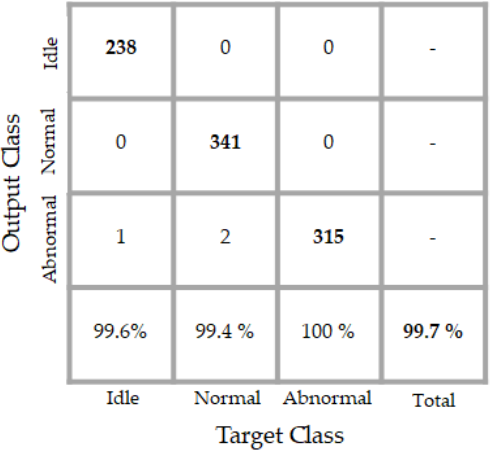
Figure 16. Confusion matrix of the classification results. “Target class” denotes the labels and “output class” denotes the actual results of the network.